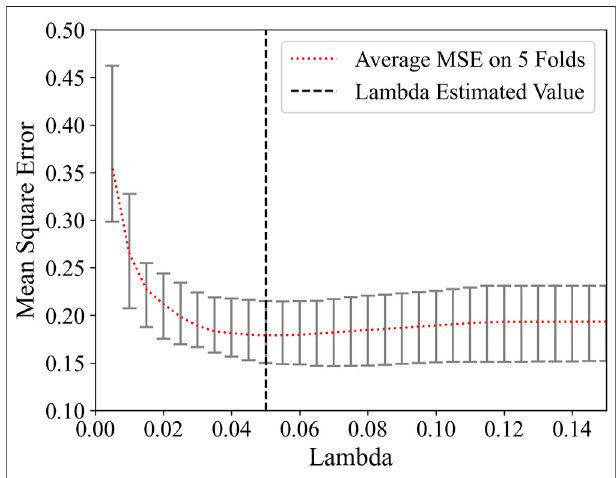
FIGURE 3 | Feature selection using the LASSO method. Relationship of MSE and λ .